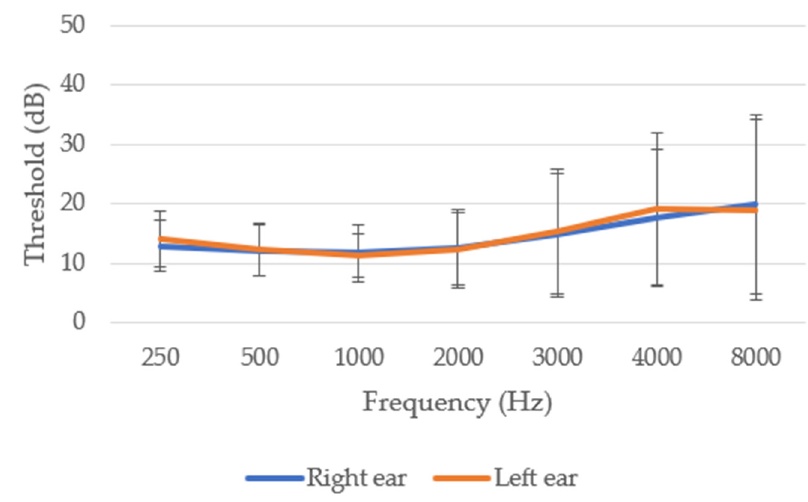
Figure 3. Audiometry of the 235 Spanish aviation pilots studied in the total sample.